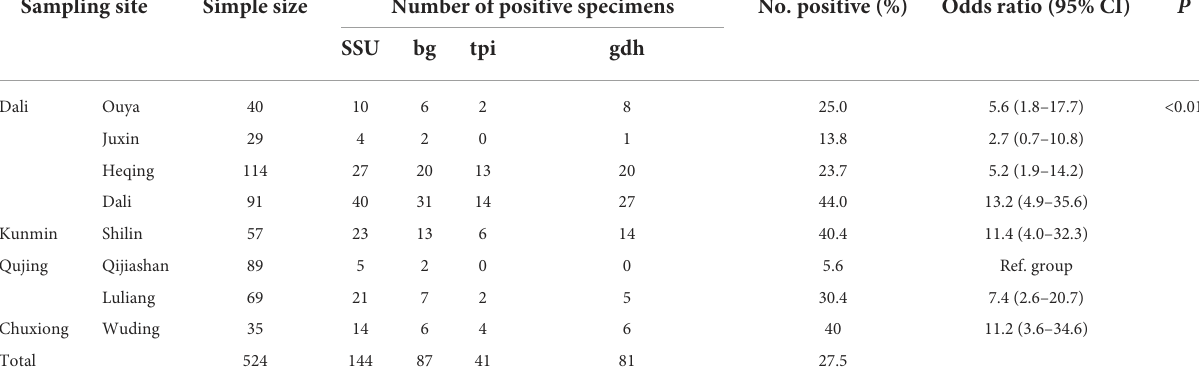
TABLE 2 Occurrence of Giardia duodenalis in Holstein cattle in Yunnan Province.